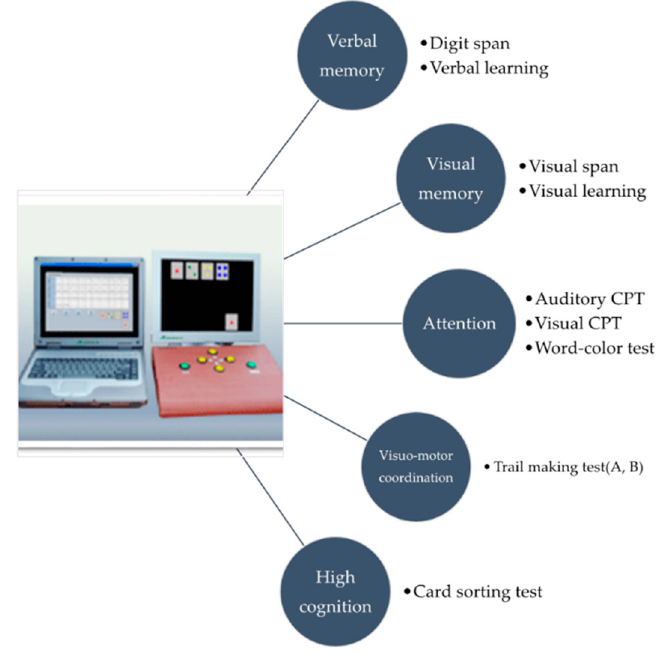
Figure 1. Computerized Neuropsychological Test.